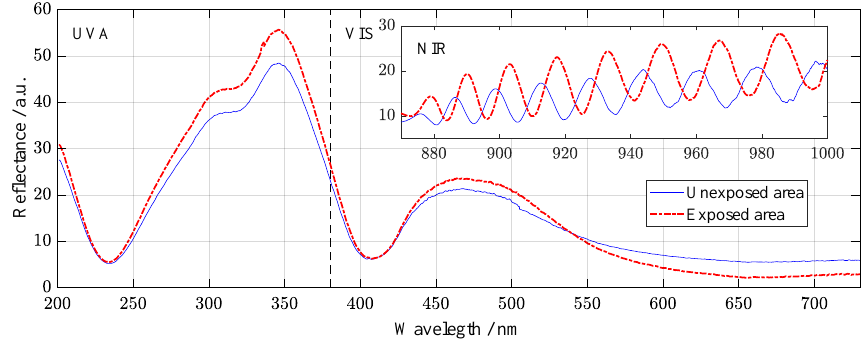
Figure 4. Reflectance measurement from supercontinuum laser irradiation. There is a significant change, especially in the near-infrared (NIR) region. These interference fringes indicate a differences in thin-films. Exposed area is measured after SL illumination of 67